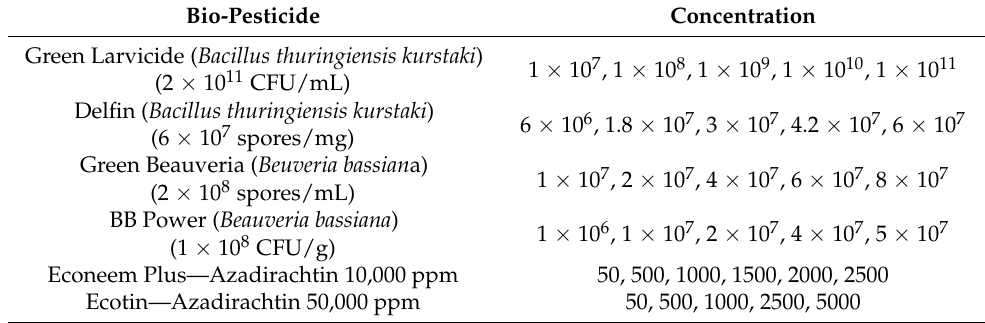
Table 2. Concentration of bio-pesticides used in the bioassays against Tuta absoluta larvae. Bio-Pesticide Concentration Green Larvicide ( Bacillus thuringiensis kurstaki